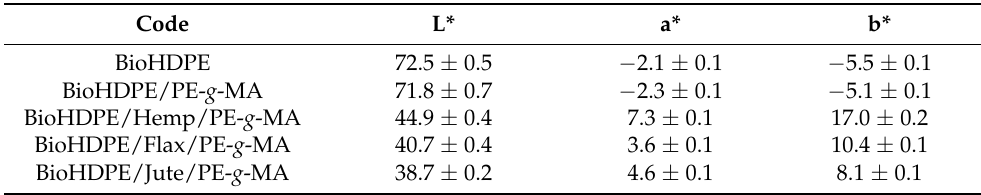
Table 6. Luminance and color coordinates (L*, a*, b*) of BioHDPE composites with different natu- ral fibers.